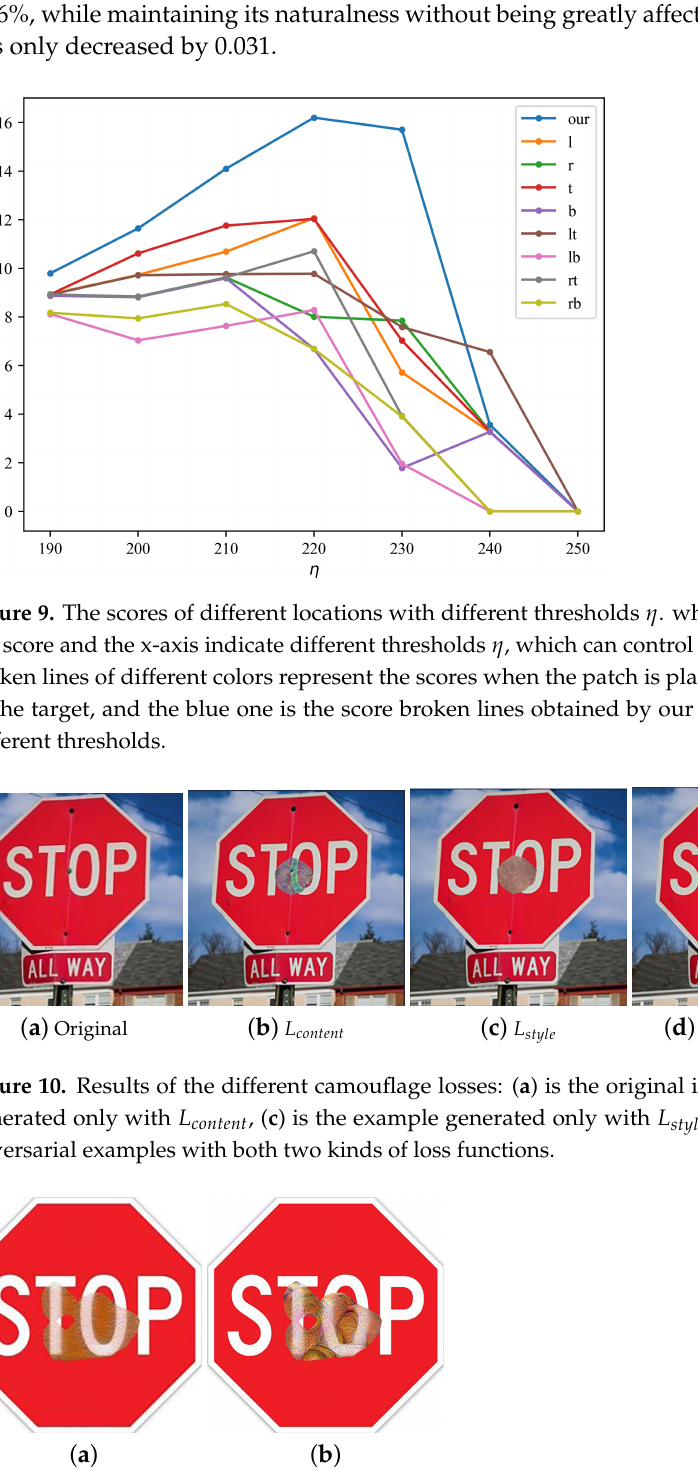
Figure 11. ( a ) is the adversarial example generated without physical adaption and ( b ) is the one with physical